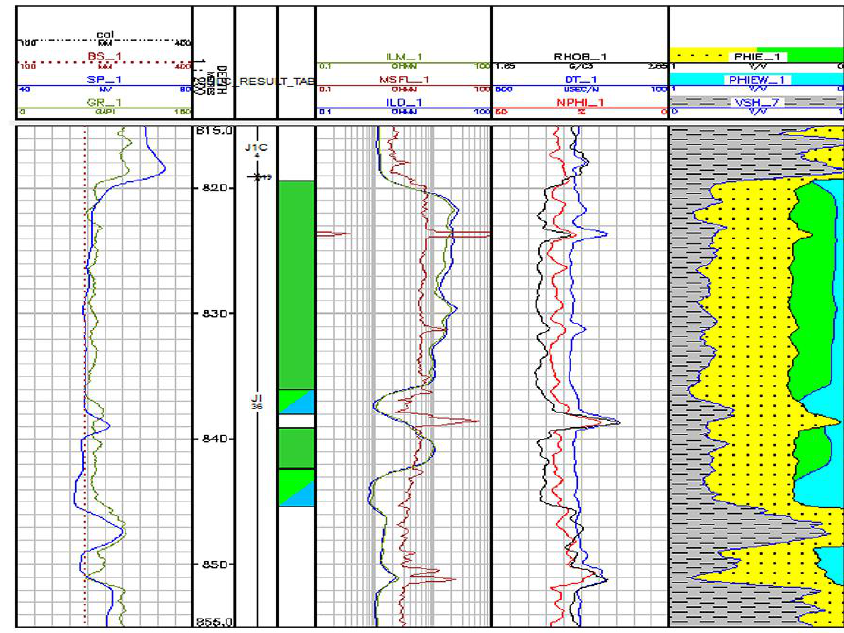
Figure 4. Interpretation of water-flooded zone of Well xx36 in P Formation.